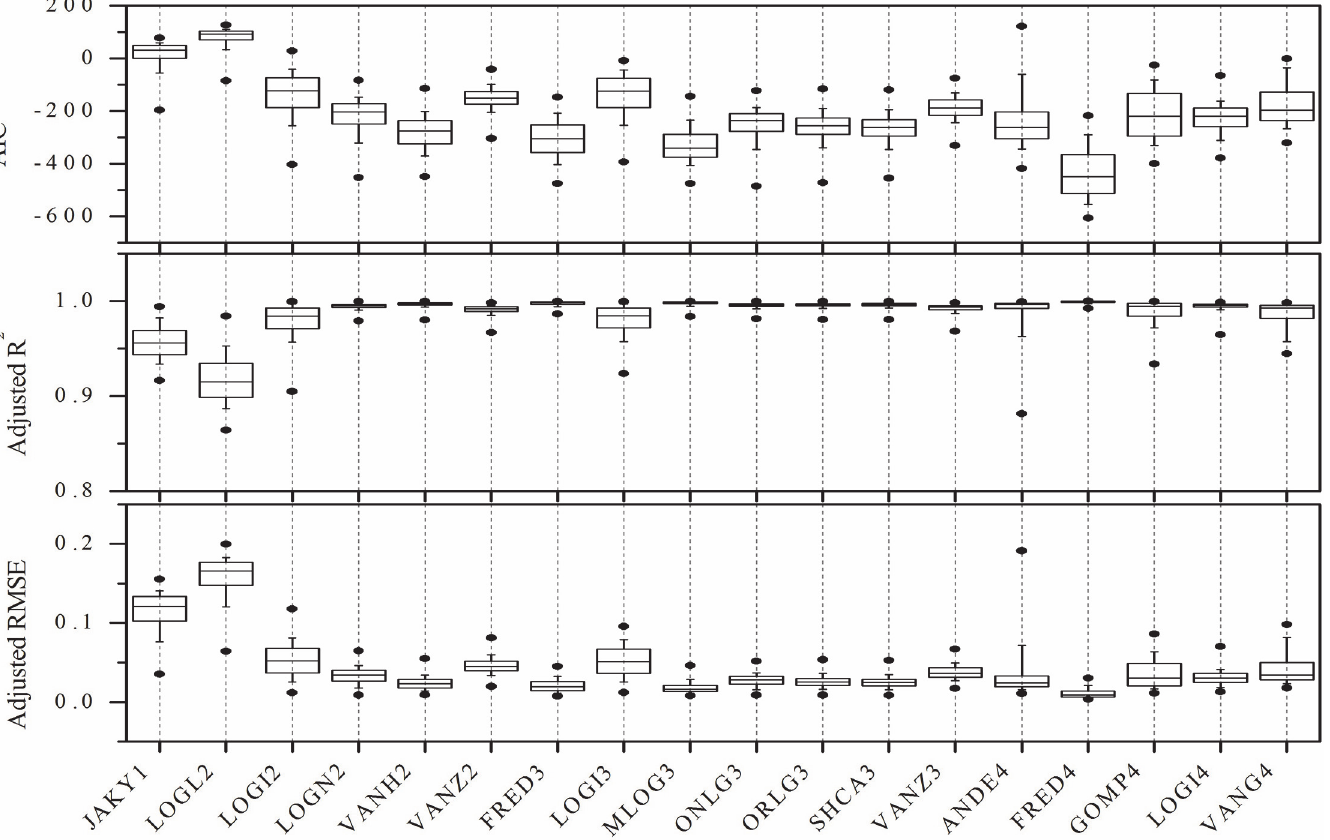
Fig 2. Performance of eighteen mathematical functions fitted to ninety-three class particle size distributions (PSD) based on soil data obtained with laser diffraction methods (LDM), in terms of Akaike ’ s information criterion ( AIC ), adjusted R 2 , and adjusted root mean square error ( RMSE